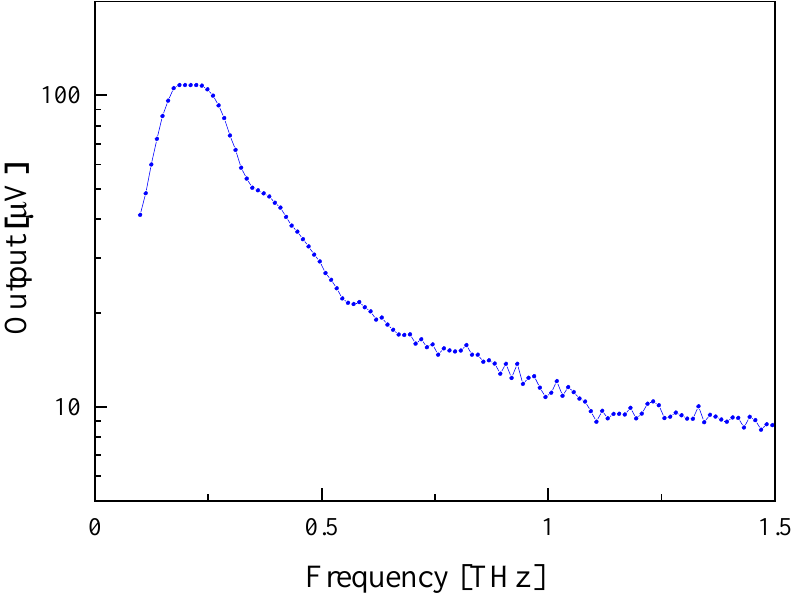
Figure 4. Frequency characteristics of the FS-THz intensity.